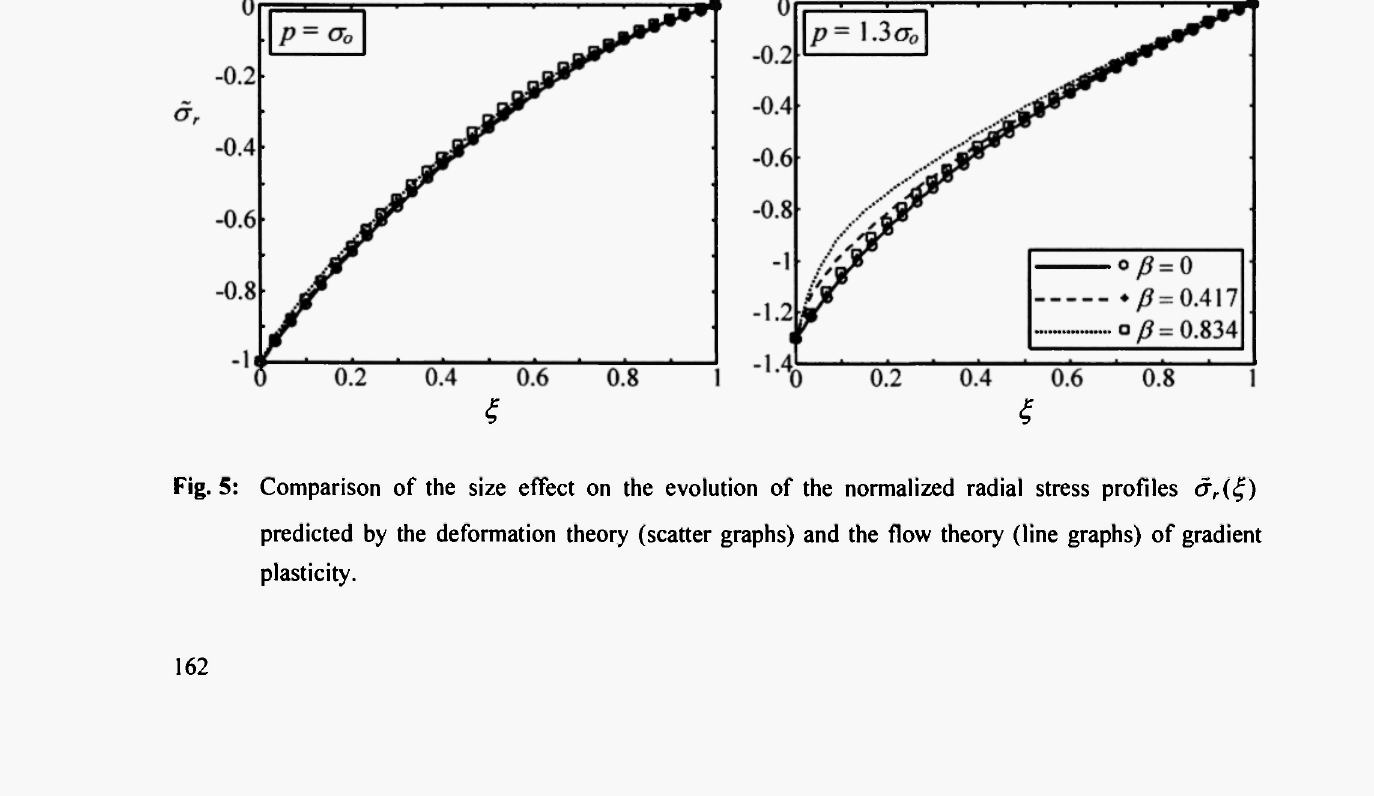
Fig. 5: Comparison of the size effect on the evolution of the normalized radial stress profiles ά Γ (ξ) predicted by the deformation theory (scatter graphs) and the flow theory (line graphs) of gradient